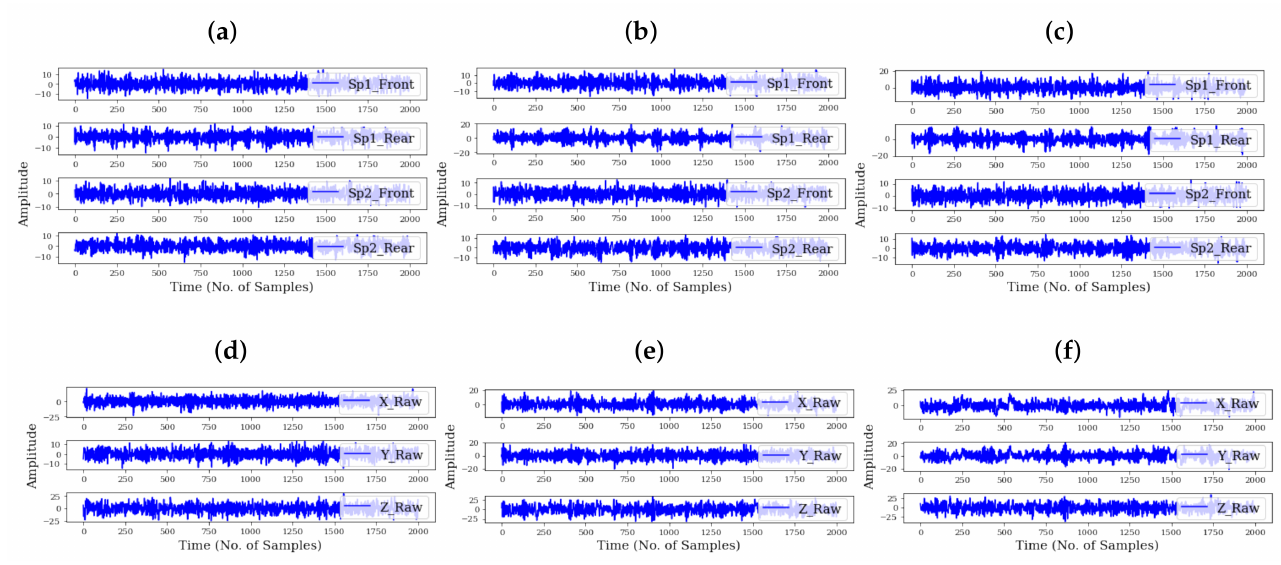
Figure 5. Raw vibration signals for ( a ) spindle at healthy/normal state, ( b ) spindle at fairly used state, ( c ) spindle at faulty state, ( d ) frame at healthy/normal state, ( e ) frame at fairly used state, and ( f ) frame at faulty state.